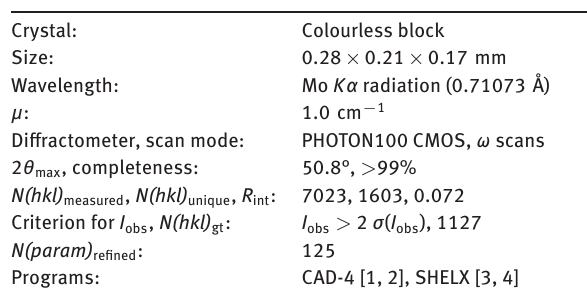
Table 1: Data collection and handling.